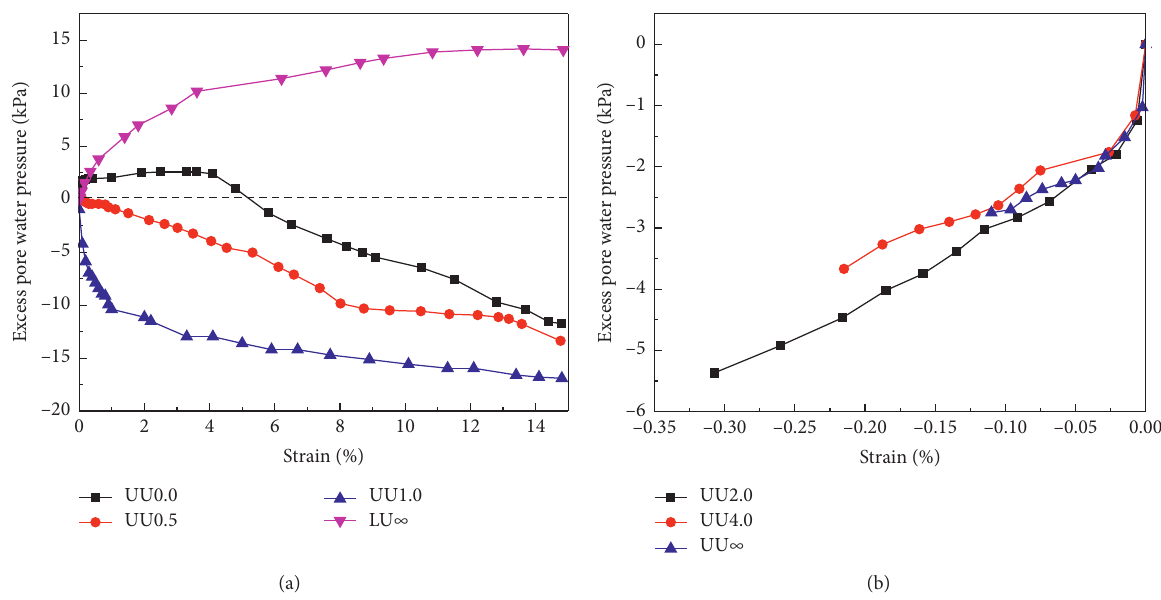
Figure 9: Strain and excess pore water pressure. (a) Compressive strain and excess pore water pressure. (b) Rebound strain and excess pore water